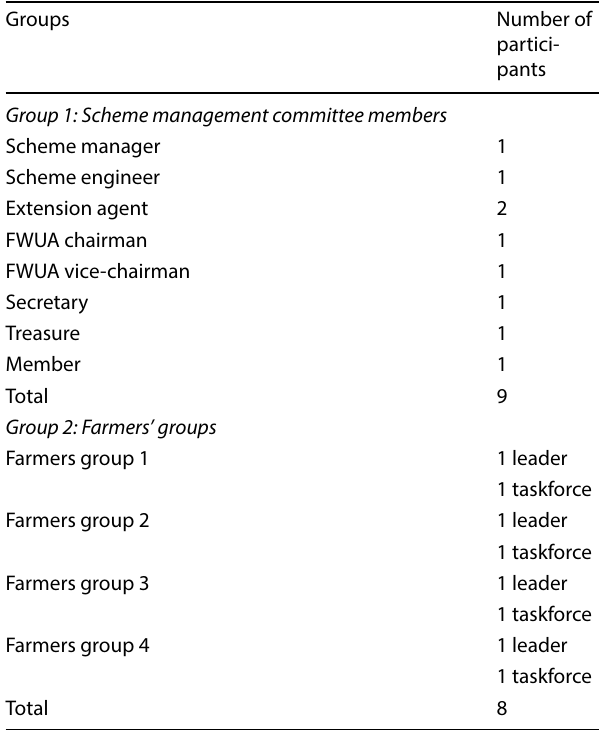
Table 4 List of participants in the focus group discussion. Source Developed by the authors Groups Number of